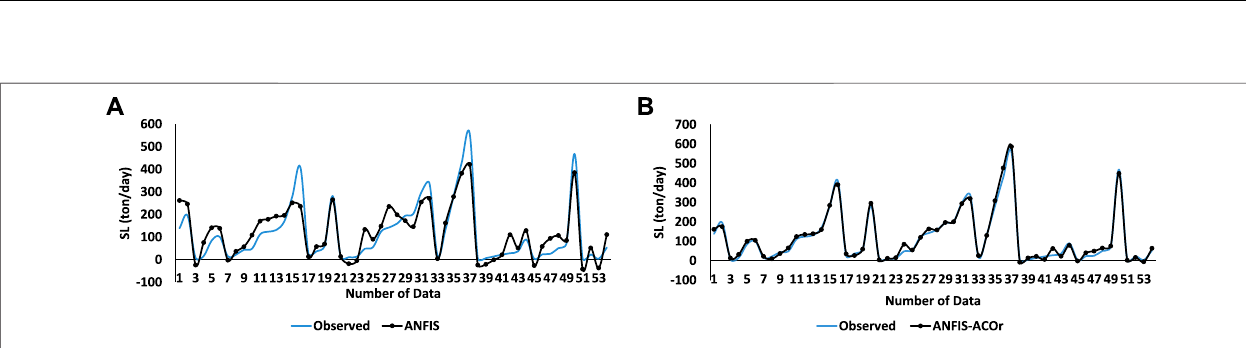
Frontiers in Environmental Science |